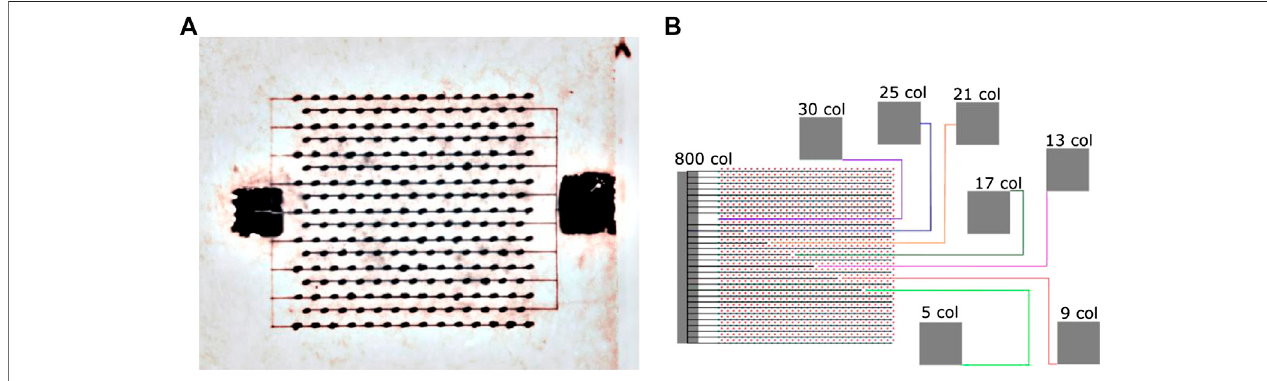
FIGURE 7 | (A) An optical microscopy image of Sensor A.The electrodes are well visible as thin dark points, while the two lateral pads, on opposite diamond surfaces, are designed to allow wire bonding. (B) A schematic representation of the connections of Sensor B into several test structures, each connected to its wire- bonding pad. All the electrodes not part of a strip-shaped test structure are short-circuited and connected to the large comb-like pad on the left of the schematic.